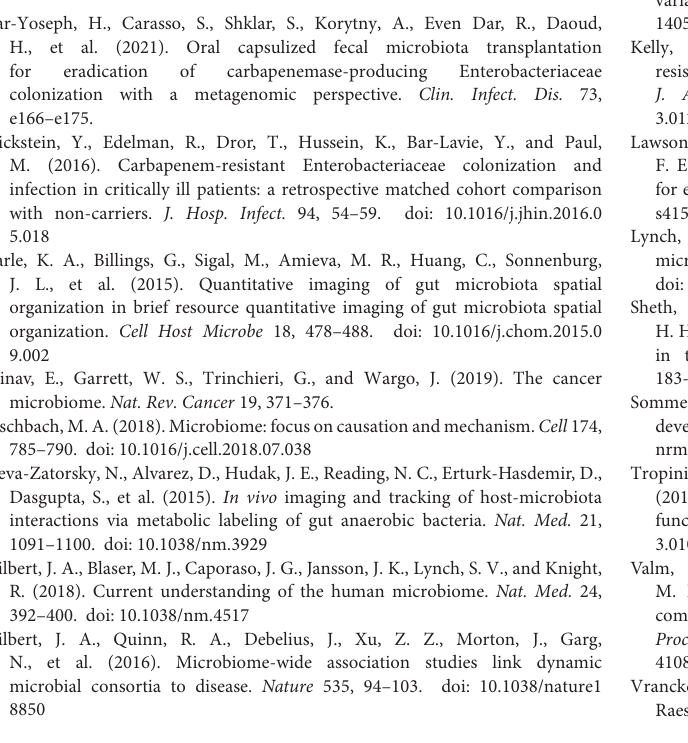
Supplementary Figure 2 | COMBICK is applicable on phylogenetically diverse human gut-derived commensals. Flow cytometry histogram plots representing labeling of 15 commensal bacteria, each labeled with two fluorophores (green: AF488, red: AF647). Bacterial strains (1–15) are listed in Supplementary Table 1 . Supplementary Figure 3 | COMBICK enables multi-fluorophore labeling of Enterobacteriaceae species using flow cytometry Labeling of an additional Enterobacteriaceae species with several fluorophores simultaneously (AF647, AF4594, AF488 and AF405). Each column represents a different fluorophore channel. (A) Flow cytometry histograms of the unlabeled bacteria. (B) Flow cytometry histograms of the labeled bacteria with 4 fluorophores simultaneously. Supplementary Figure 4 | COMBICK enables multi-fluorophore labeling of different Enterobacteriaceae species using confocal microscopy. Labeling of an Enterobacteriaceae species with several fluorophores simultaneously (AF647, AF4594, AF488, and AF405). Each column represents a different fluorophore channel. Confocal images representing the labeled Enterobacteriaceae species with four fluorophores simultaneously. Supplementary Figure 5 | COMBICK labeling is not applicable on different Klebsiella species. Labeling of different Klebsiella species with several fluorophores simultaneously (AF647, AF4594, AF488, and AF405). Each column represents a different fluorophore channel. (A,C,E) Histograms of flow cytometry analysis of unlabeled Klebsiella species. (B,D,F) Flow cytometry histograms of Klebsiella species labeled using COMBICK. Supplementary Figure 6 | COMBICK enables labeling anaerobic bacteria isolated directly from stool. Labeling live anaerobic bacteria directly isolated from stool. Flow cytometry histograms of the isolated bacteria labeled by COMBICK. Each column represents a different fluorophore channel. The upper row of each bacteria represents the unlabeled control, and the lower row the bacteria labeled with both fluorophores. The bacterial isolates were named HH_#, (# for sequential arbitrary numbers).